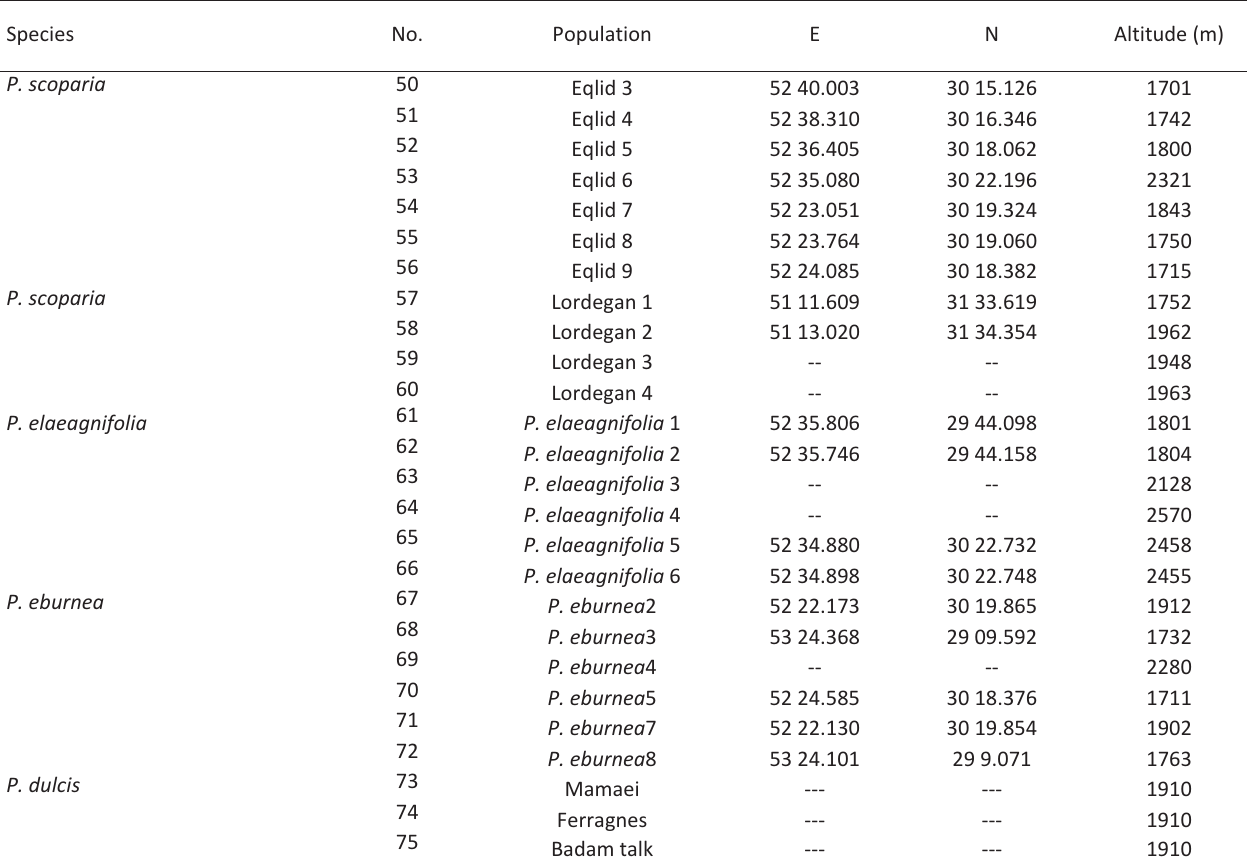
Table 1 ­ List of the studied genotypes with indication of their regions and geographical coordinates of the collection sites Species No.